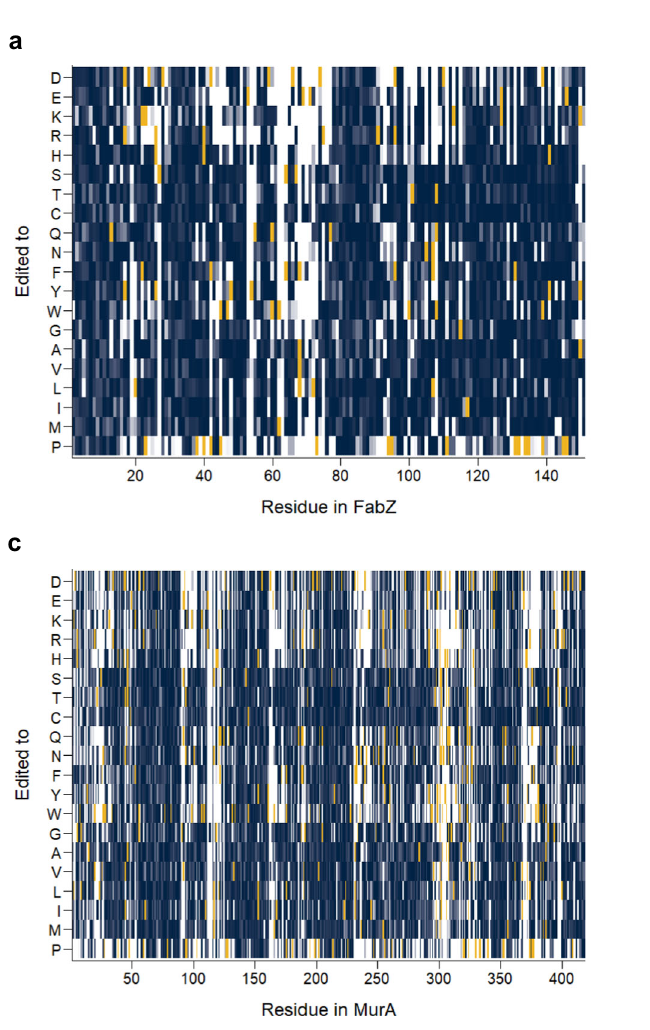
Fig.4|Analysisofsaturationeditinglibrariescanbeusedtoidentifyimportant residues. These heat maps display the presence or absence of each amino acid substitution in the saturation editing library of FabZ ( a ), LpxC ( b ) and MurA ( c ). Edits that were not detected after 15 generations of growth are shown in white (meanreadcount=0). The mean normalized readcounts of other editsare shown on a blue color scale. To obtain these values, read counts after 15 generations of